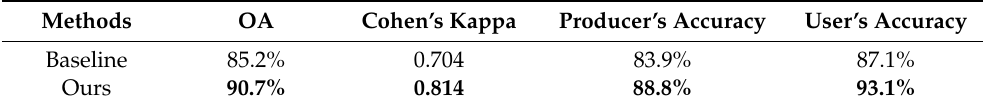
Table 2. Testing Table 2. Testing results.